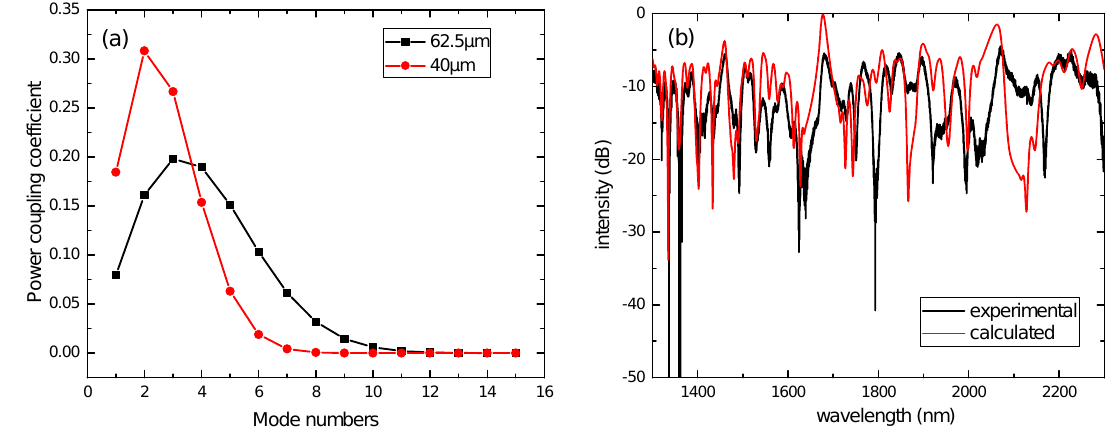
Figure 2. ( a ) The power coupling coefficient at different mode numbers with radius of 40 and 62.5 µ m; ( b ) the calculative and experimental transmission spectra of SNCS structure with a NCF = 62.5 µ m and z NCF = 54